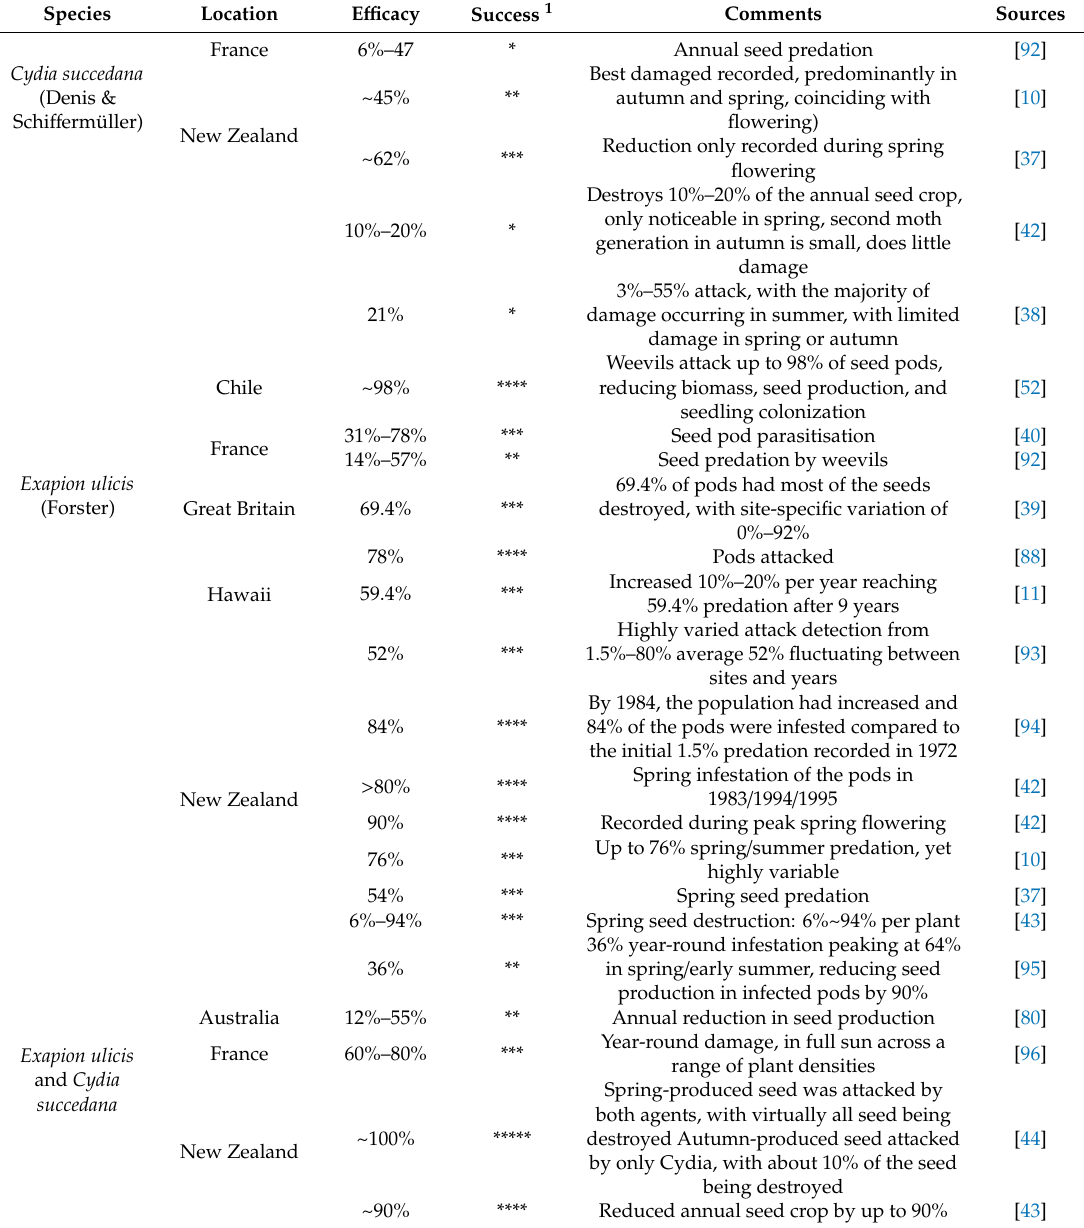
Table A2. Biological controls (seed-feeders) and their success in reducing plant vigour and population size of common